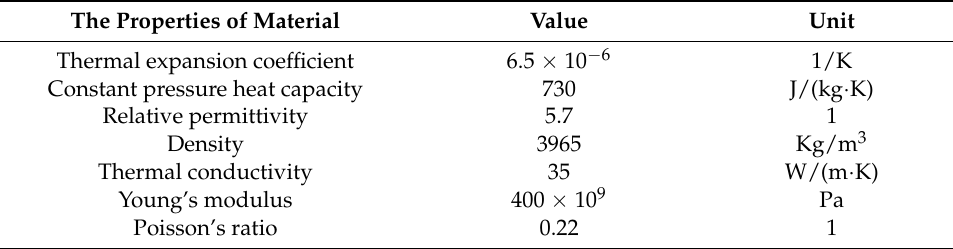
Table 5. The parameters of